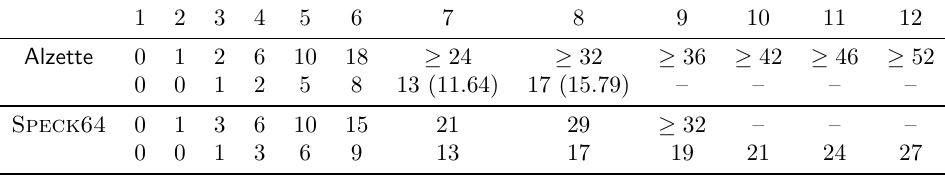
Table 4: Bounds for Alzette compared to Speck64 [BSS + 13]. The first line shows − log where 𝑝 is the maximum expected differential trail probability and the second line shows − log 𝑐 , where 𝑐 is the maximum expected absolute linear trail correlation. The value set 2 in parenthesis corresponds to the maximum absolute correlation of the linear hull taking clustering into account, derived by experimental verification. For Speck64 , the differential bounds are taken from [BVC16] and linear bounds are taken from [FWG + 16,